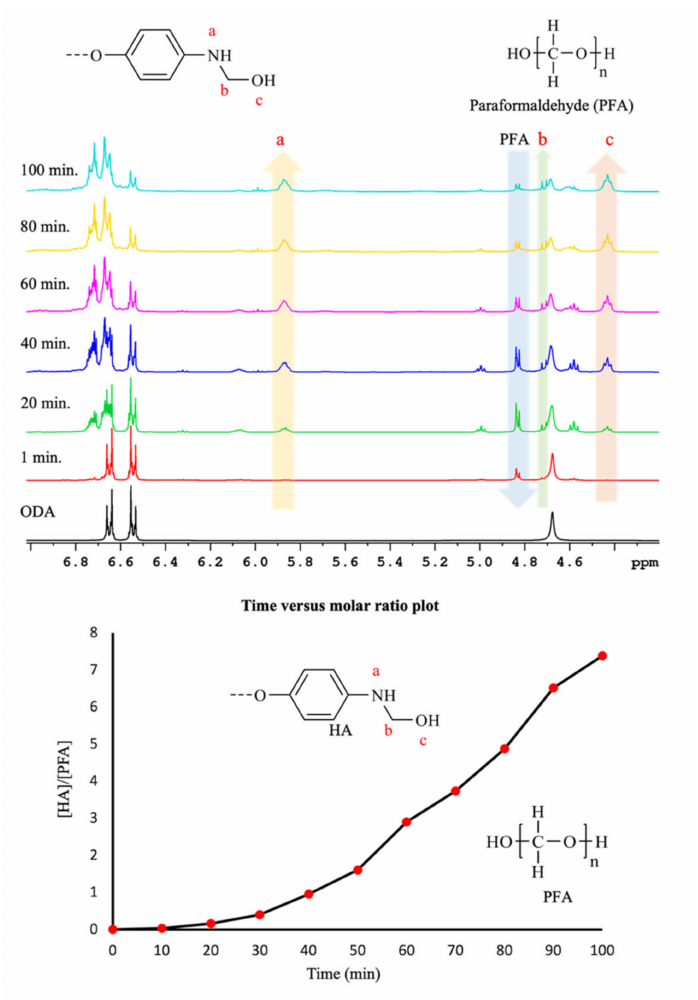
Figure 4. 1 H-NMR spectra of ODA-hemiaminal bond formation at a probe temperature of 55 ◦ C acquired after 10 min intervals up to 100 min. Variation in the molar ratio of hemiaminal and PFA based on relative integral values of –NH– protons of hemiaminal bond and –CH 2 – protons of